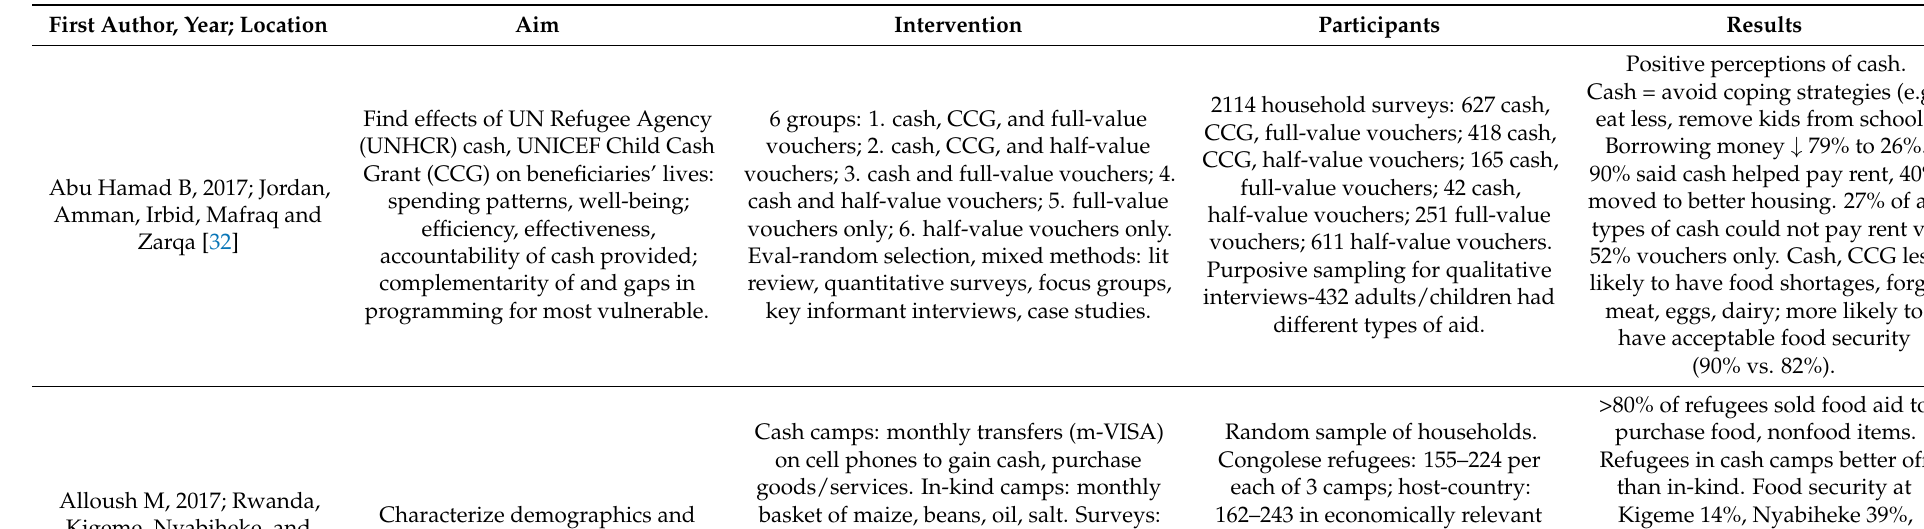
Table 1. Characteristics of Sources of